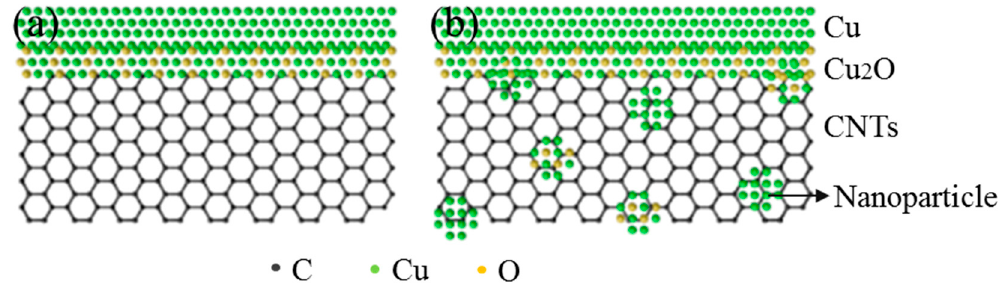
Figure 10. ( a ) Interface diagram of CNT-Cu composite; ( b ) Interface diagram of SP-CNT-Cu composite.